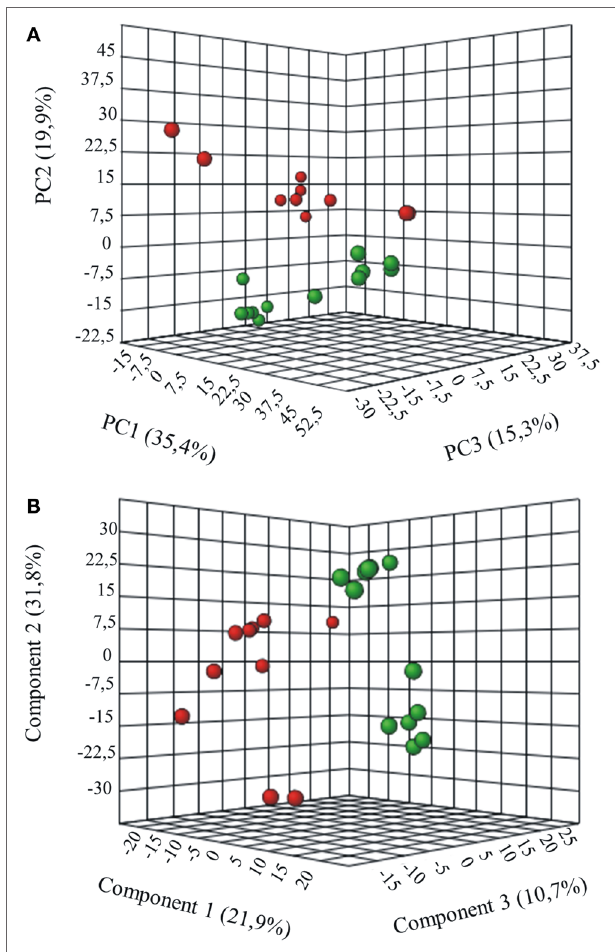
FigUre 3 | Multivariate statistical analysis of metabolomics data from control and G6PD − donors. Three-dimensional principal component analysis (PCA) and partial least squares-discriminate analysis (PLS-DA) score plots are shown in (a) and (B) , respectively. Control sample groups are in red; G6PD − sample groups are in